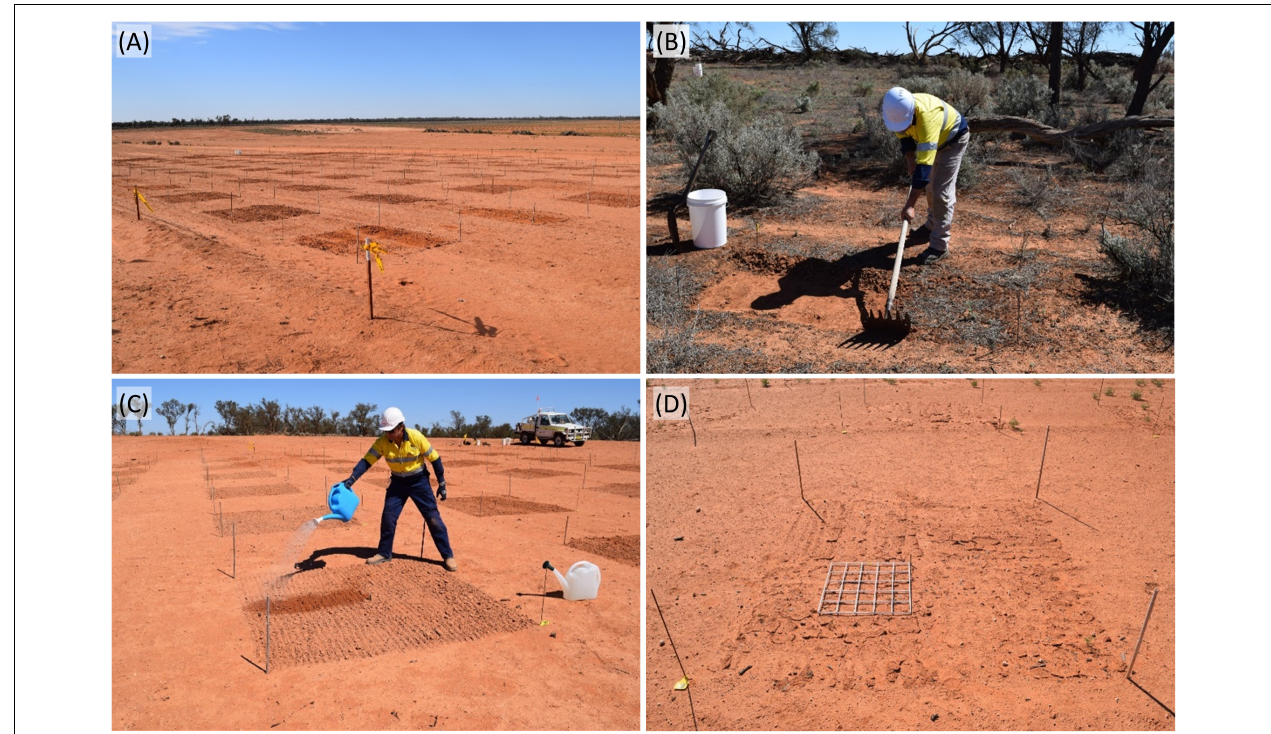
FIGURE 1 | Biocrust trial on a former topsoil storage area: (A) ninety plots of 4 m 2 were established with a buffer of 2 m separating each plot, (B) square plots (1 m 2 ) of cryptogamic crust were harvested from nearby native vegetation to 1 cm depth with a rake-hoe, (C) each plot was raked lightly with a rake-hoe to provide micro-topography and hand-watered with 18 L of reverse osmosis water from a watering can, and (D) plot showing 0.25 m 2 quadrat on the surface ready for monitoring using the center bamboo peg as a center pivot point; four of these 0.25 m 2 quadrats were sampled per plot at each monitoring